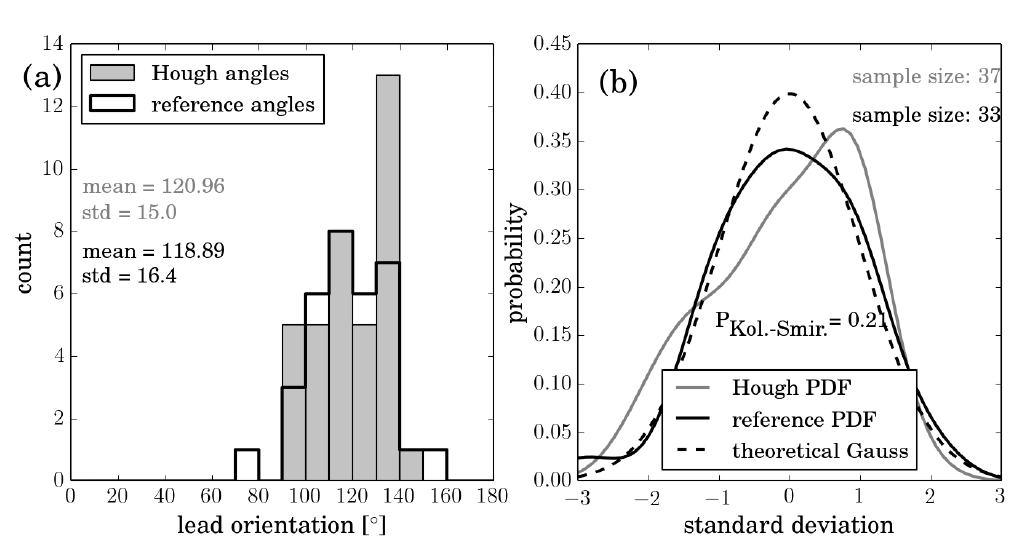
Figure 7. Comparison between lead orientations detected by the Hough transform with reference lead orientations in a histogram ( a ) and as probability density functions ( b ) in the Fram Strait on 14 March 2011. The Gauss curve in (b) is shown as reference.